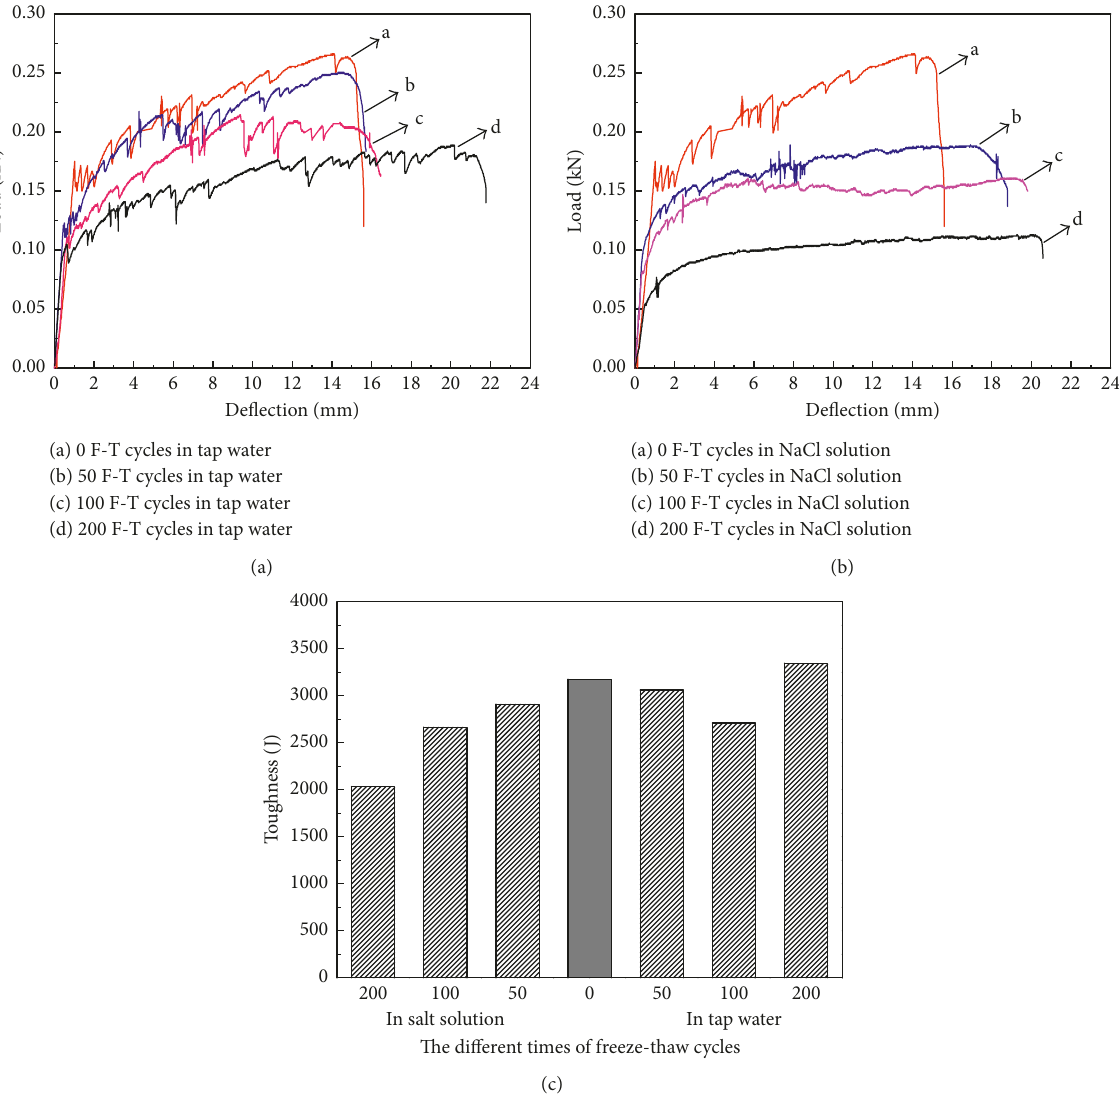
Figure 7: The load-deflection of ECC (70% FA) subjected to different times of freeze-thaw cycles: (a) in tap water, (b) in sodium chloride (NaCl) solution, and (c) the corresponding toughness with different times of freeze-thaw